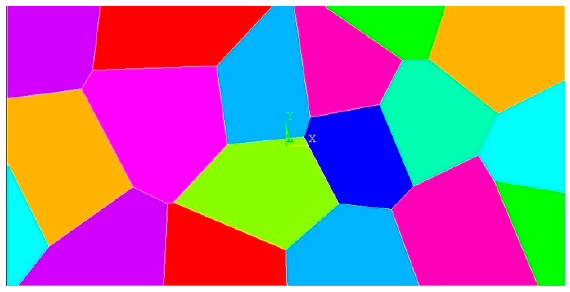
Figure 9. Model for the static analysis of Mo polycrystal, composed of 18 randomly orientated grains with respect to the x–y coordinate system located at the centre of the model.